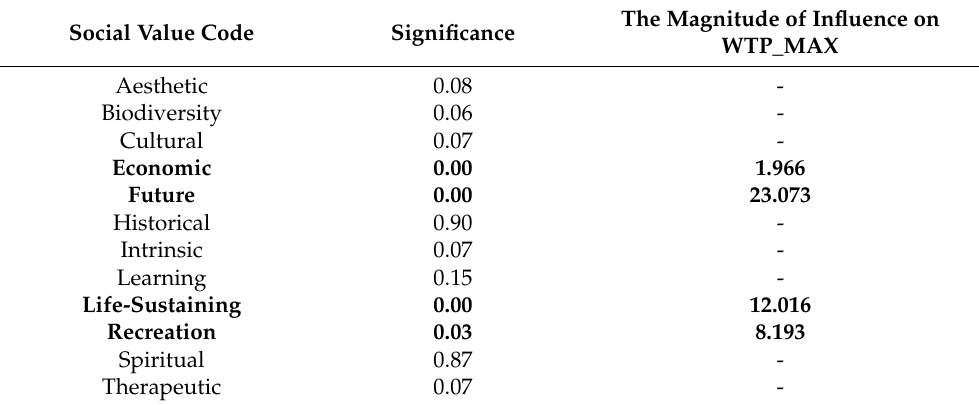
Table 5. Impact on the WTP_MAX by the local residents’ perception of certain social values in Los Horcones